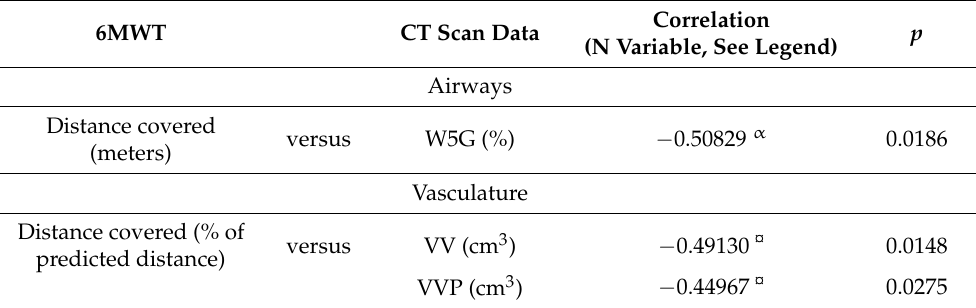
Table 4. Correlation analysis of six-minute walk test data versus CT variables in the COPD group.